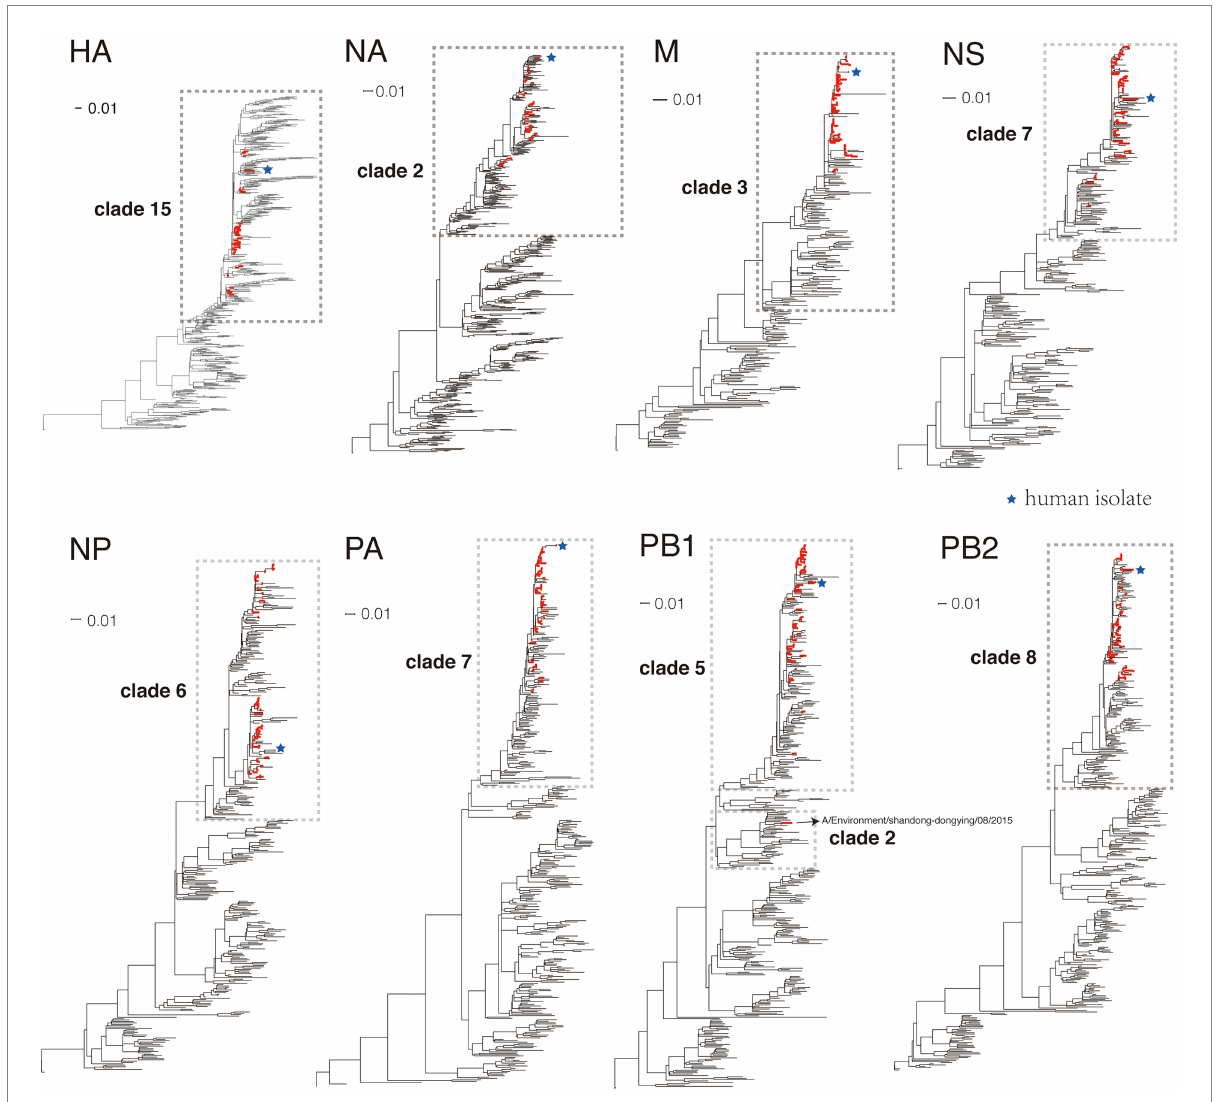
FIGURE 3 The phylogeny of H9N2 viruses on each segment. The newly sequenced H9N2 viruses were colored in red in the trees. The human isolate was marked with blue stars. The details of these trees were shown in Supplementary Figure